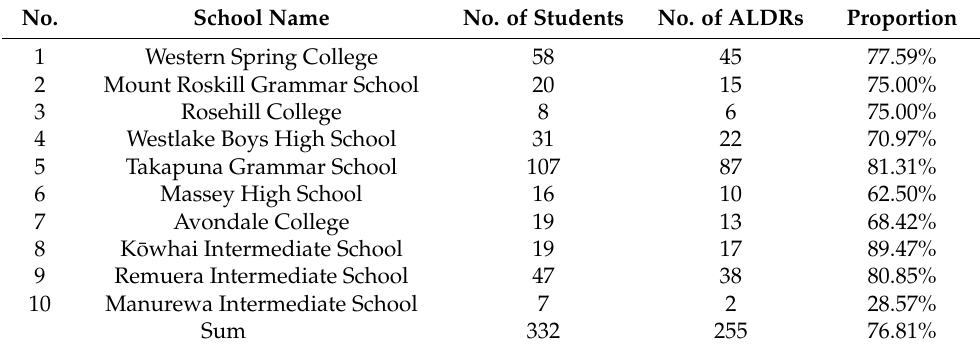
Table 3. The proportion of ALDRs found for students in each school.